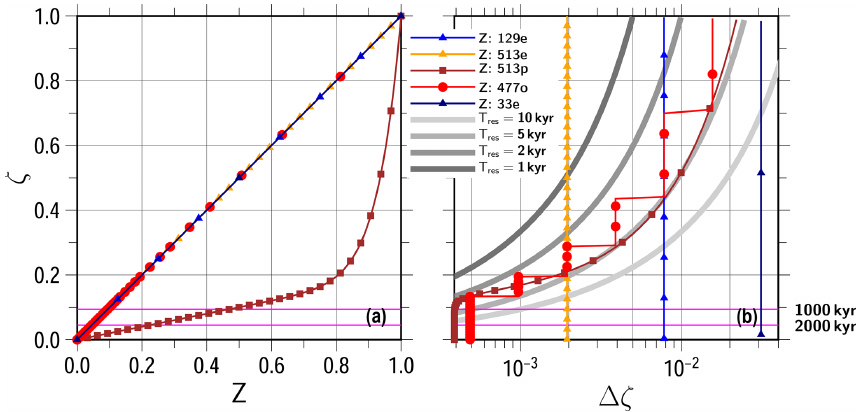
Figure 14. Vertical discretization adopted in the present study: (a) Z vs. ζ (b) (cid:49)ζ vs. ζ . Five patterns are shown: uniform grid spacing of 129 levels (129e), that of 513 levels (513e), a smooth non-uniform discretization (513p; see text), a non-smooth, non-uniform discretization (477o; see text), and uniform grid spacing of 33 levels (33e). Symbols are plotted for every 16 vertical levels. The four gray lines in panel (b) correspond to the layer thickness necessary to resolve 10, 5, 2, and 1kyr differences under the condition of M s = 1 . 5cmyr − 1 , M b = 0, and H = 3000m. The two horizontal magenta lines correspond to the depth needed to reach 1000 and 2000kyr under the same conditions.